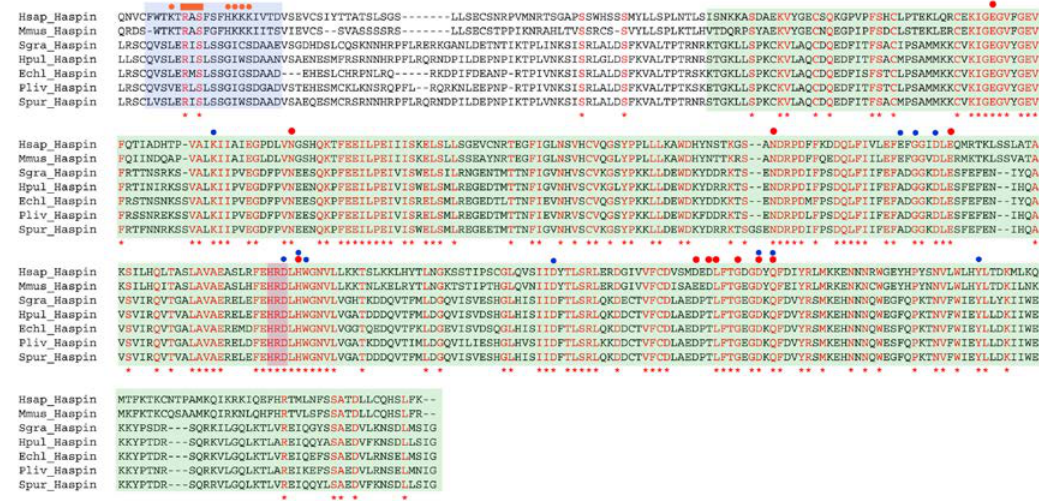
Figure 4. The echinoidea Haspin homologs display a conserved Ser/Thr kinase domain. Clustal-W protein alignment showing the C-terminal portion of Haspin in different mammalia and echinoidea species. Invariant amino acid positions are shown in red and labelled with asterisks. The Haspin Ser/Thr kinase domain is shaded in green and its HRD catalytic loop is shown in red. Residues implicated in H3 recognition and/or interacting with ATP/Mg 2+ in the human Haspin are respectively marked with red and blue dots [34,39,40]. The vertebrate HBIS motif and its homolog region in sea urchins are shaded in blue. The positively charged residues of the vertebrate motif are marked with orange dots [42], but do not appear to be conserved. The RAS motif, where the Ser is one of the residues phosphorylated by the Polo-kinase during Haspin activation is indicated by an orange rectangle [42]. We aligned the following sequences: Hsap, Homo sapiens (NP_114171.2); Mmus, Mus musculus (NP_038578.2); Spur, Strongylocentrotus purpuratus (JT120475.1); Sgra, Sphaerechinus granularis (GAVR01006044.1) and (GAVR01015122.1); Echl, Evechinus chloroticus (GAPB01047772.1);